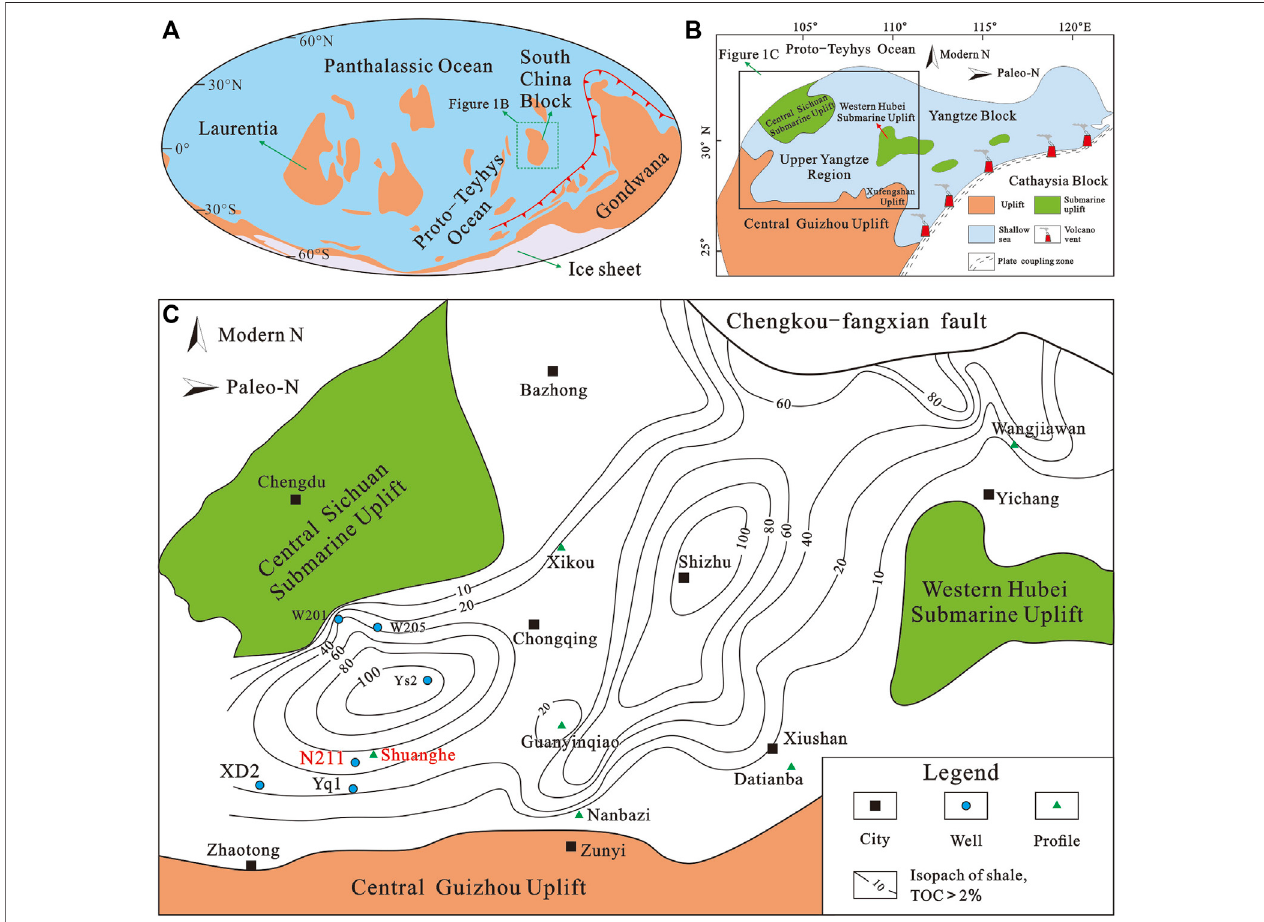
FIGURE1| GeologicalsettingoftheUpperYangtzeRegionduringtheLateOrdovicianthroughtheEarlySilurian. (A) PalaeogeographiclocationoftheSouthChina Block during the Late Ordovician through the Early Silurian. The South China Block was situated in the equatorial tropical or subtropical region on the western margin of the Gondwana continent at approximately 90 ° counterclockwise from its present-day location, according to Cocks and Torsvik (2002) and Huang et al. (2020). (B) Paleogeographic map of the Yangtze Block during the Late Ordovician through the Early Silurian. The present-day northern margin of the Yangtze Region was its westernmarginduringtheLateOrdovicianthroughtheEarlySilurian.TheUpperYangtzeRegionissurroundedbytheCentralSichuanSubmarineUplift,CentralGuizhou Uplift, and Western Hubei Submarine Uplift, according to Zhou et al. (2015); Wang et al. (2017); Liu et al. (2017), and Tang et al. (2020). (C) Distribution of the organic matter-rich shales in the Wufeng – Longmaxi Formation in the Upper Yangtze Region. Those with a TOC > 2% have a thickness up to approximately 100 m, and the thickest organic-rich shales are near Shizhu and well Ys2, according to Wang et al. (2017).